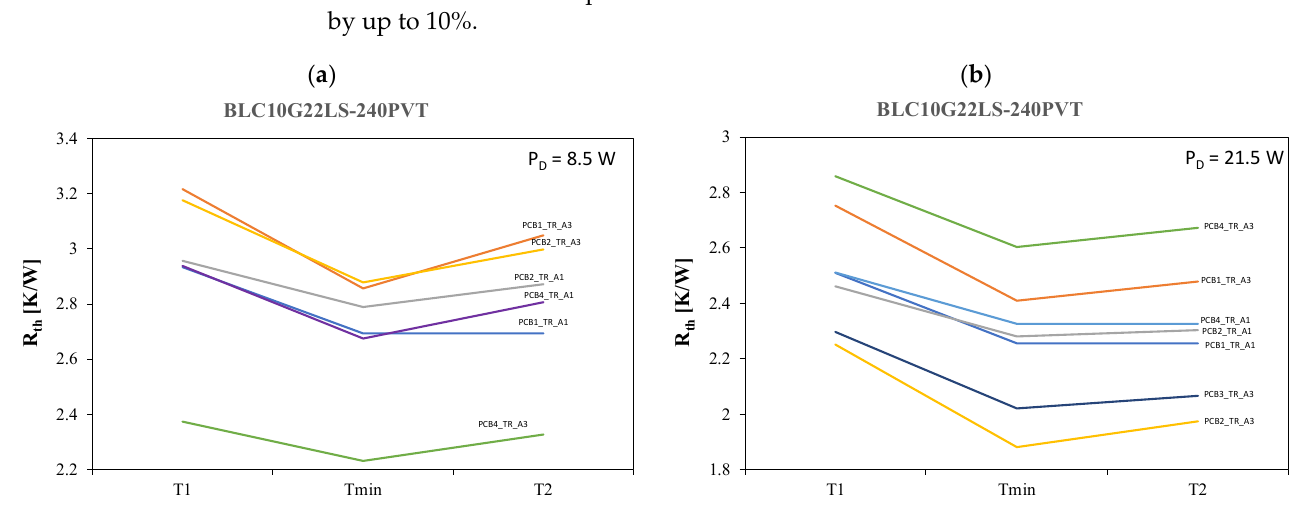
Figure 15. Method of determining the temperature values T emp1 , T emp2 , and T min from the thermogram of the temperature distribution on the transistor case.